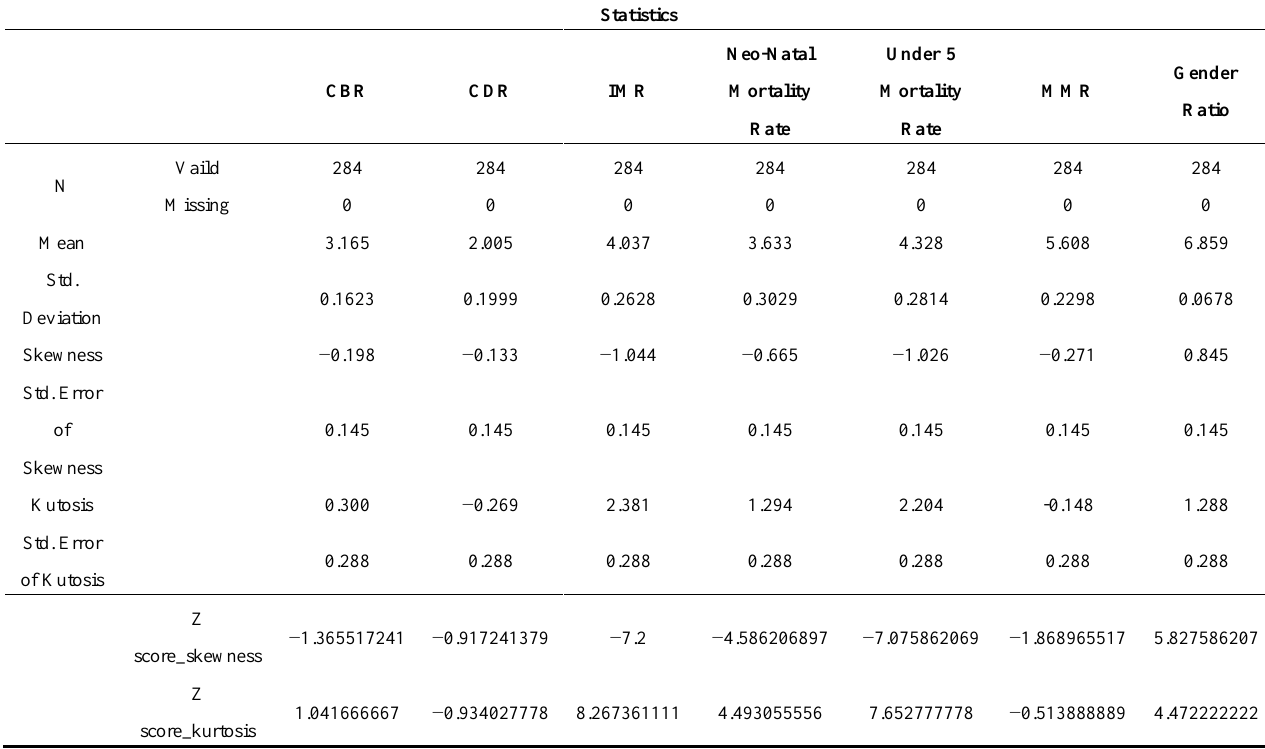
Table 2. Skewness and kurtosis of health metrics (log